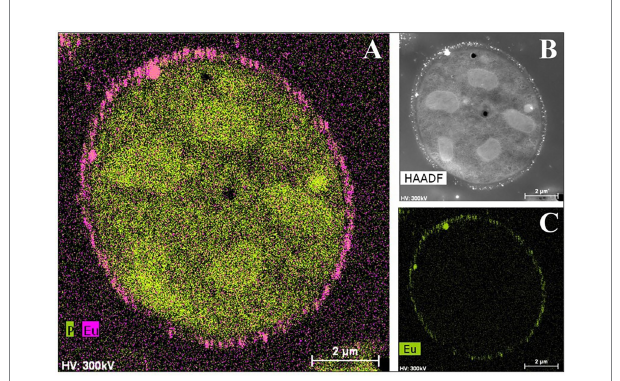
FIGURE 7 HAADF-STEM micrographs of a thin section and EDX element distribution maps showing the Eu biosorption to the cell surface of Rhodotorula mucilaginosa BII-R8. A : P and Eu elemental mapping image; B : HAADF image; C : Eu elemental mapping image (Lopez- Fernandez et al.,